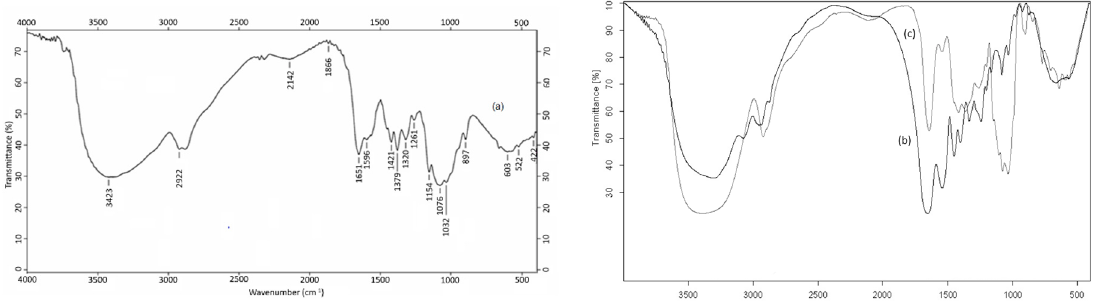
Figure 9. FT-IR spectra of pure chitosan (curve a), pure gelatin (curve b) and gelatin–chitosan-AuNPs (mixture of gelatin 0.2 (%, w / v ) and chitosan 0.06 (%, w / v ) at pH 6.0 (curve c). Table 3. FT-IR band positions of pure gelatin, pure chitosan, and gelatin–chitosan mixture-AgNPs presented in Figure 9.